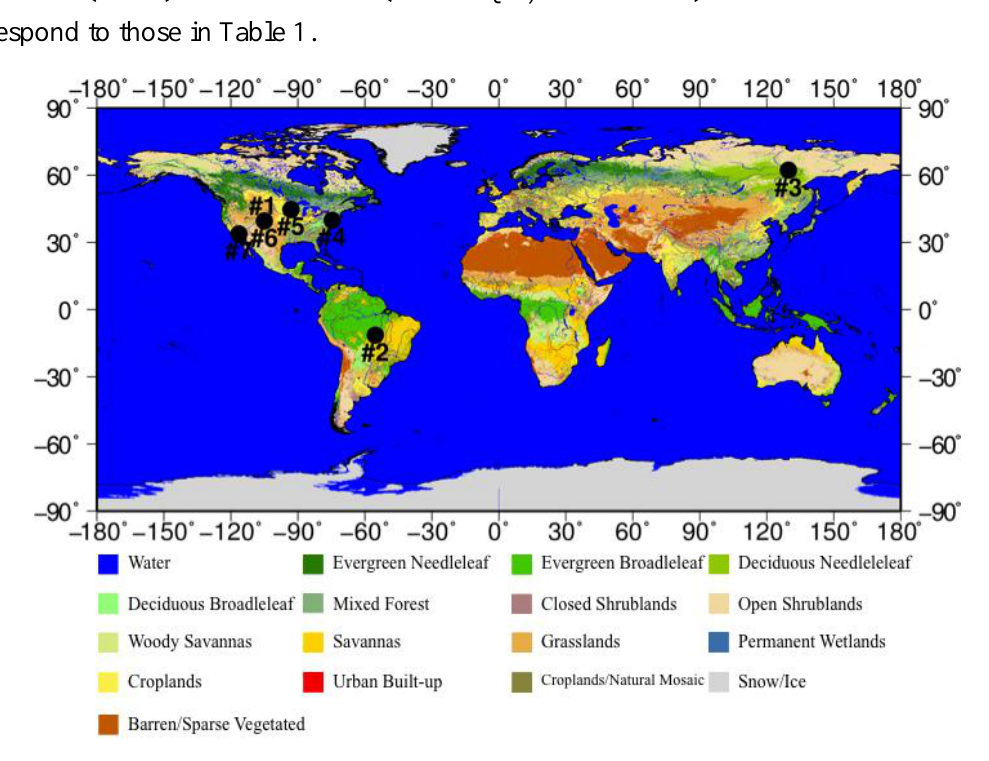
Figure 2. FLUXNET sites used in ASTER and MODIS Enhanced Vegetation Index (EVI) compatibility